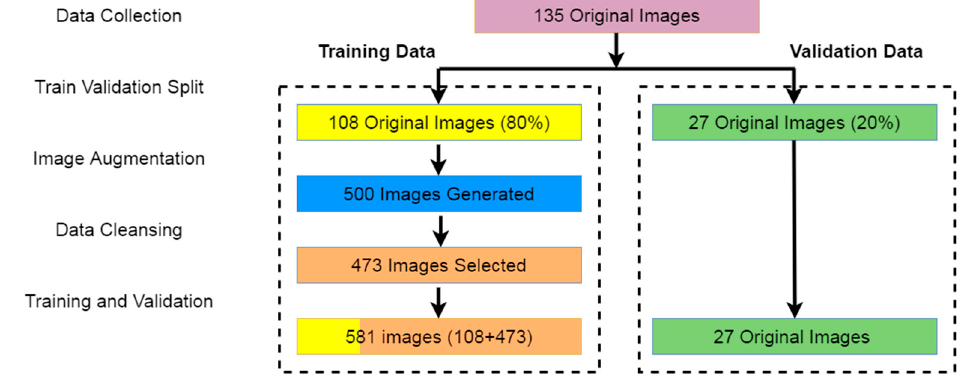
Figure 5. Training and validation data.